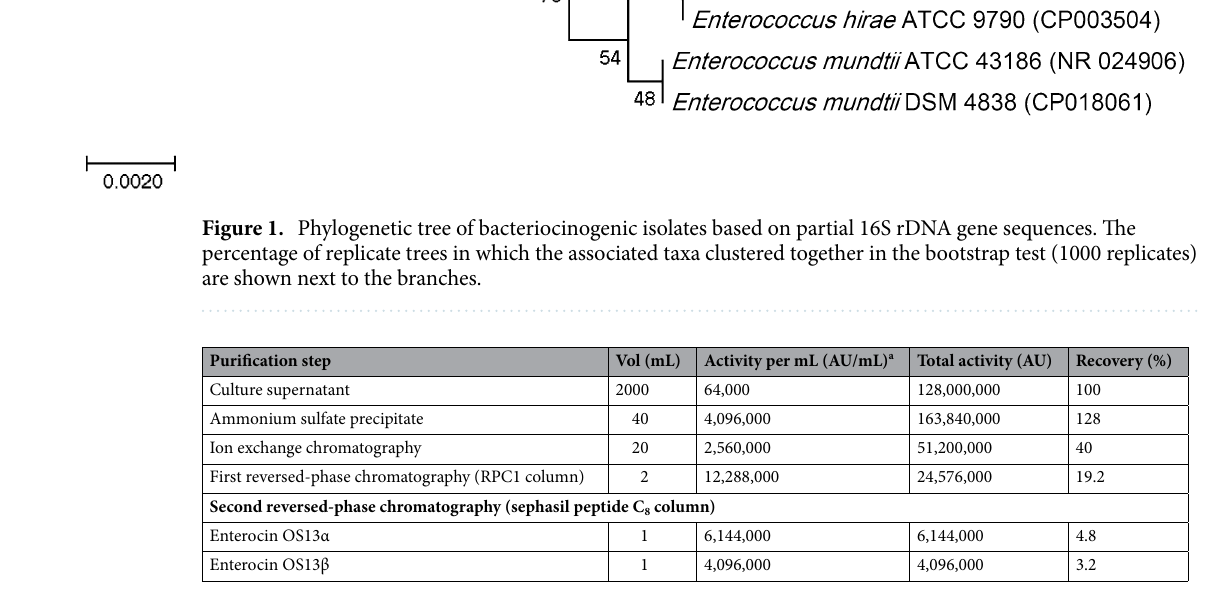
Table 2. Purification of enterocin OS13. a (AU/mL), Arbitrary unit per mL.